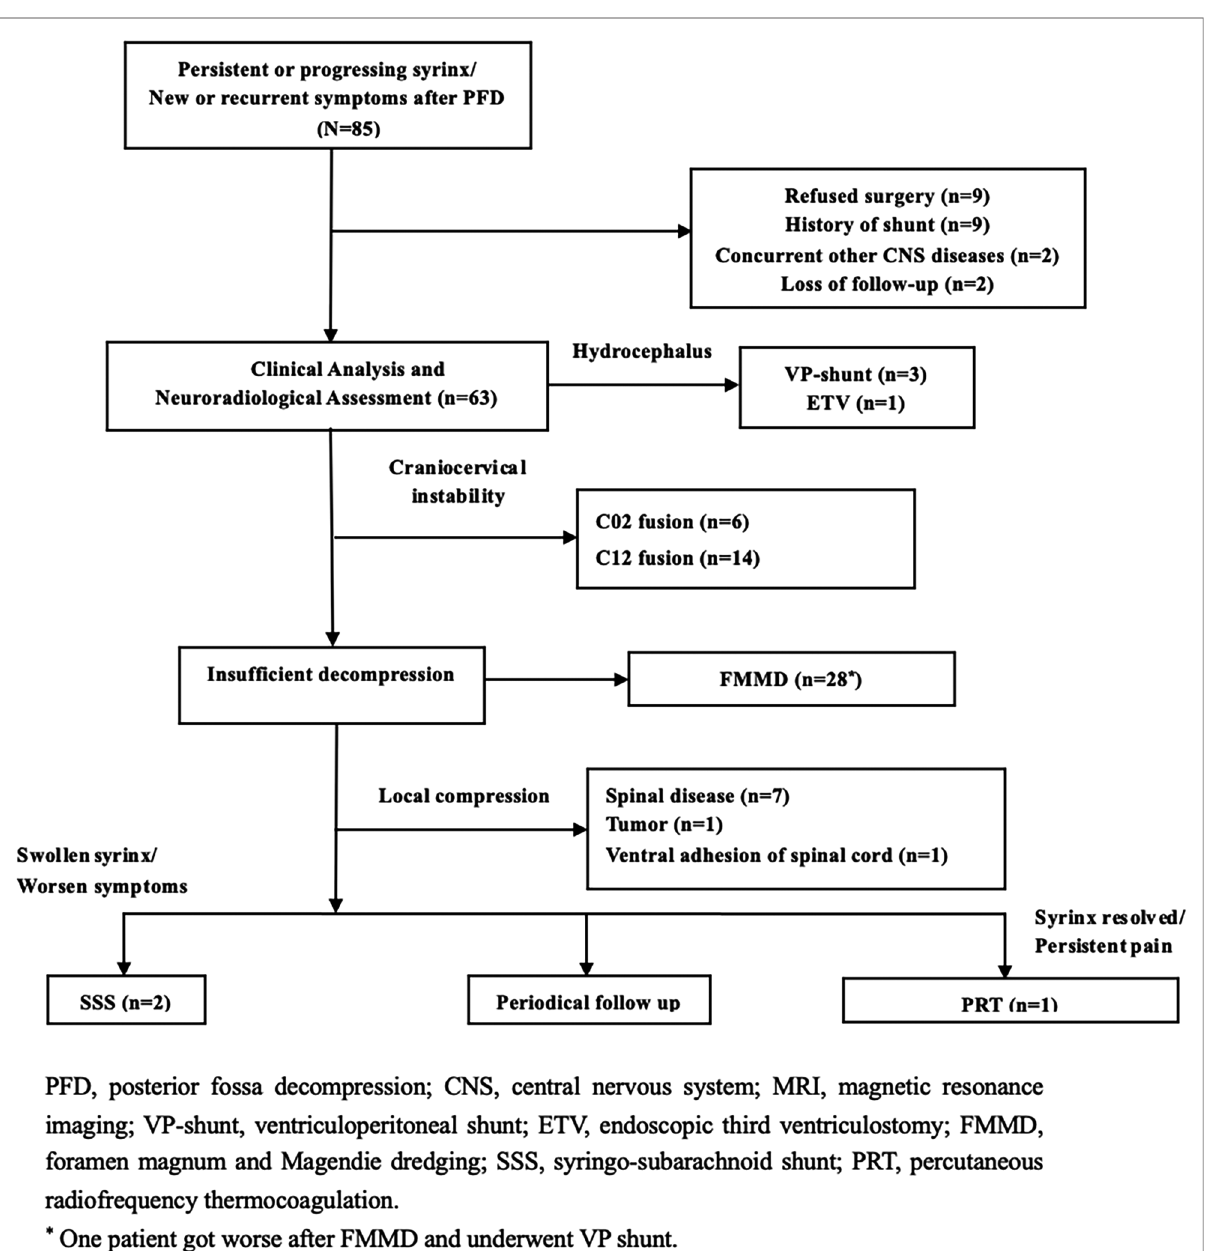
FIGURE 1 The treatment algorithm categorization and surgical strategy of 85 consecutive failed PFD patients between 2015 and